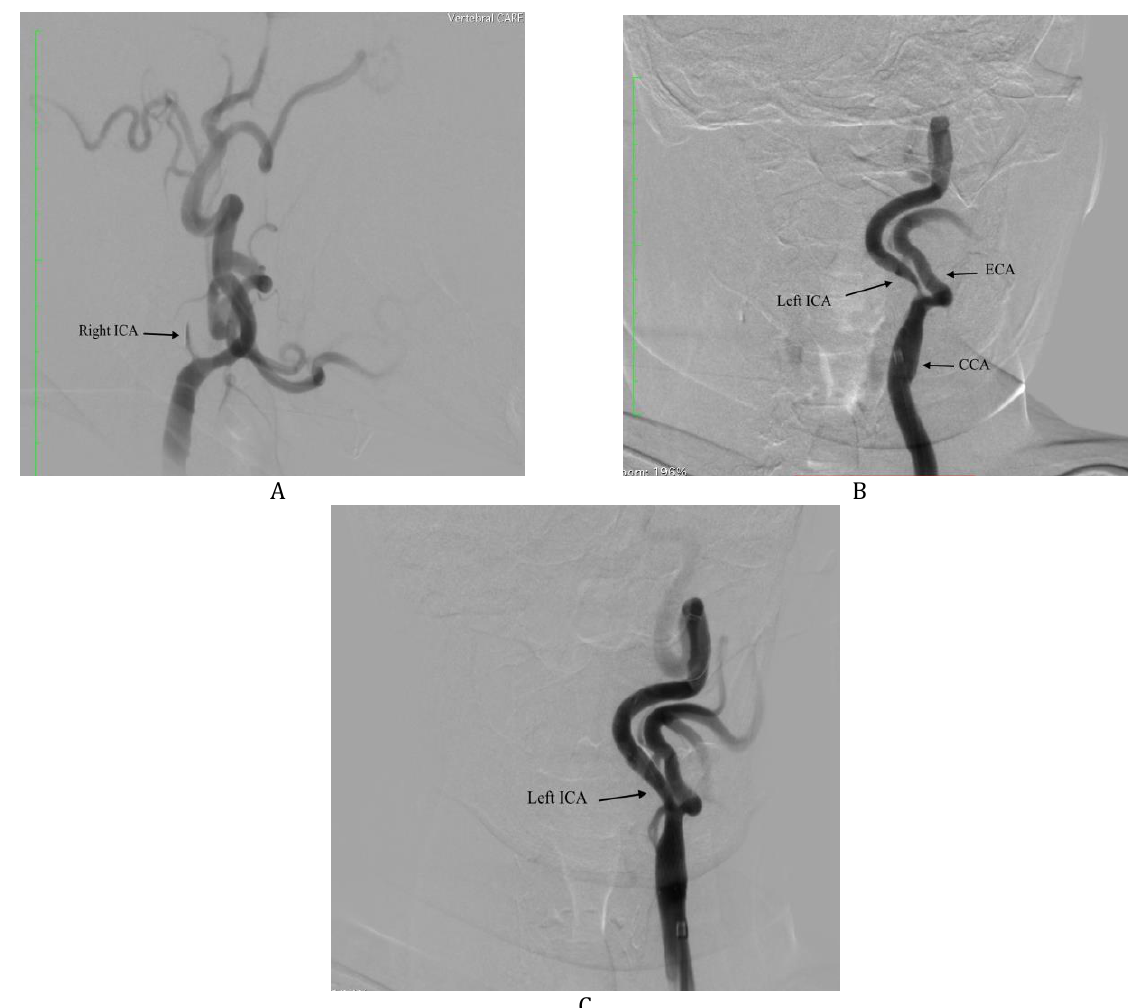
Figure 2 . A: Right internal carotid artery (ICA) occluded at origin following probably dissection, B: Left ICA, high-grade stenosis at origin, C: Left ICA and post-carotid angioplasty and stenting